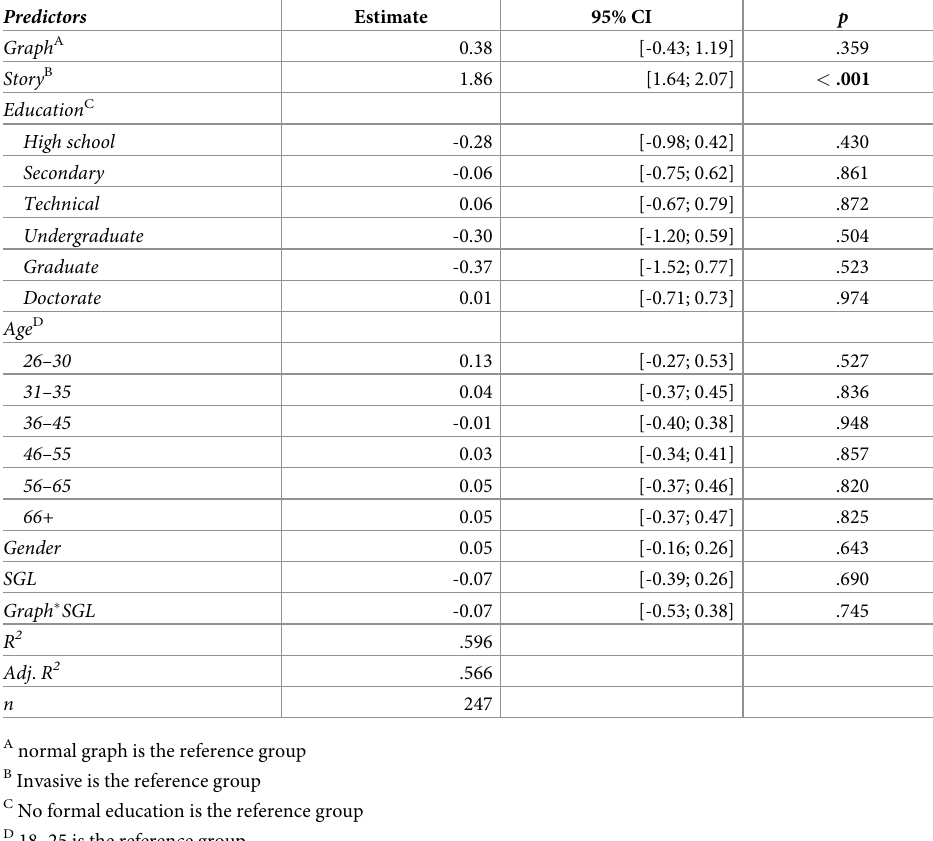
Table 3. Model summary for the multiple linear regression model with judgment as the dependent